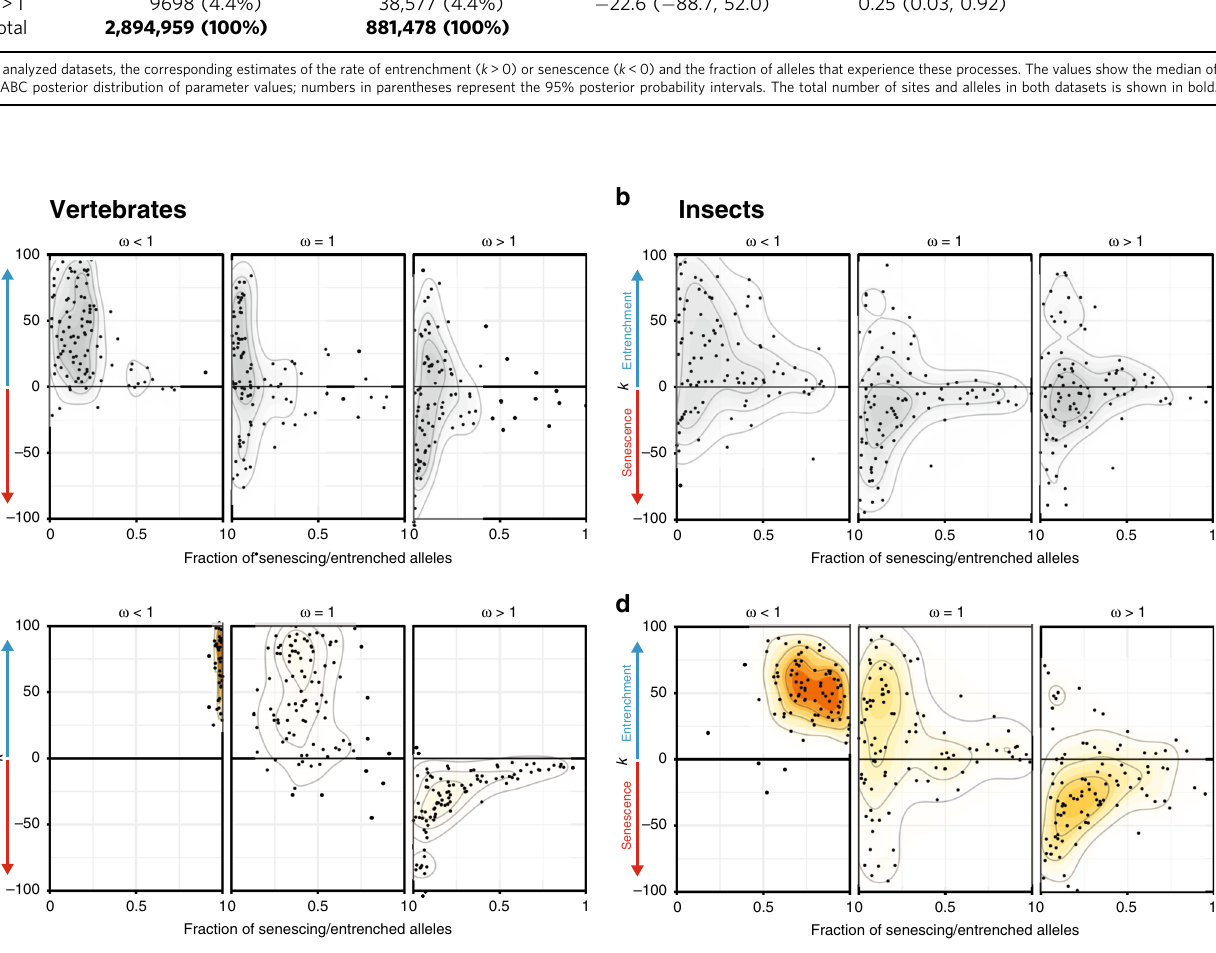
Fig. 5 Senescence and entrenchment in protein sequences of vertebrates and insects. Plots provide ABC estimates of the rate of senescence or entrenchment k and the fraction of alleles with changing fi tness for protein sequences of vertebrates and insects. For each dataset, the posterior distribution of parameters under 1% acceptance threshold after local ridge regression adjustment is shown. Positive values of k correspond to entrenchment, while negative values of k correspond to senescence of the current allele. a , b Simulated data under the stationary model using the vertebrate ( a ) or insect ( b ) phylogeny and distribution of ω values. c , d In real genomic data of vertebrates ( c ) or insects ( d ), sites under negative selection show strong entrenchment, neutral sites demonstrate the intermediate signal, and positively selected sites are